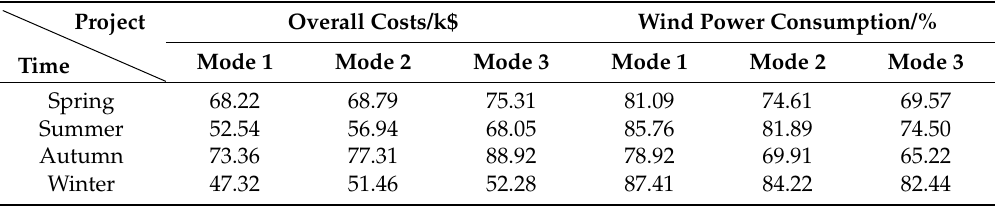
Table 10. Comparison of different model scheduling results.